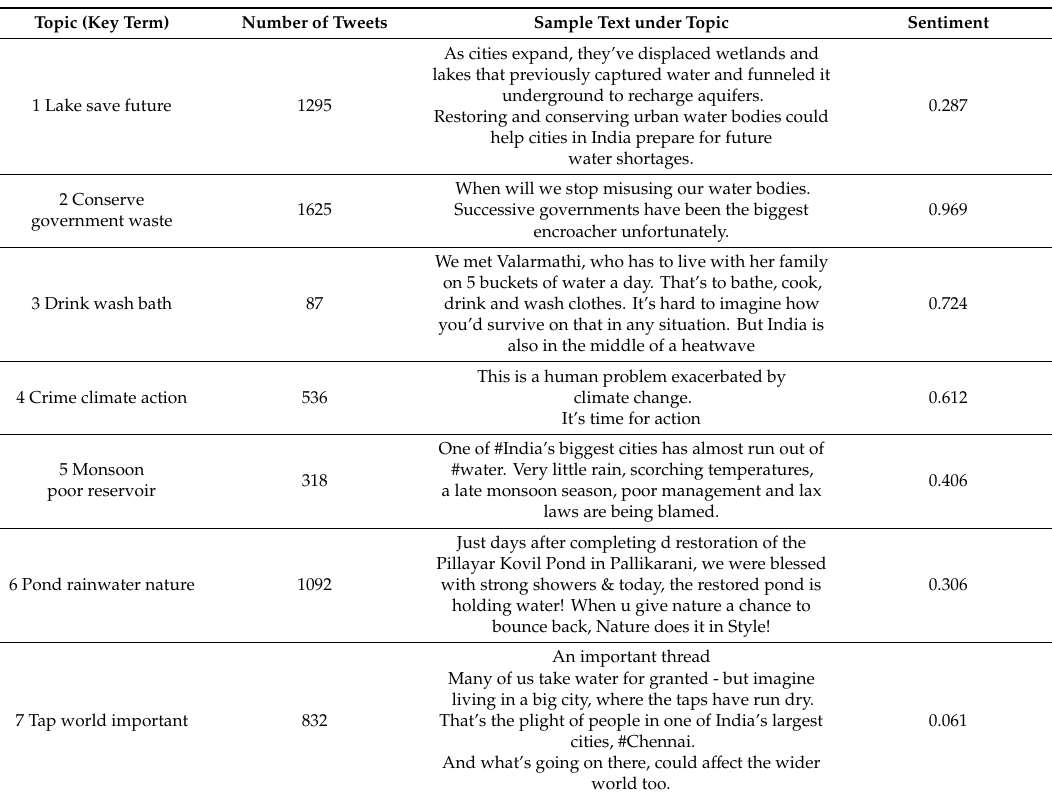
Table 3. Number of tweets, sample tweet, and sentiment of each topic.